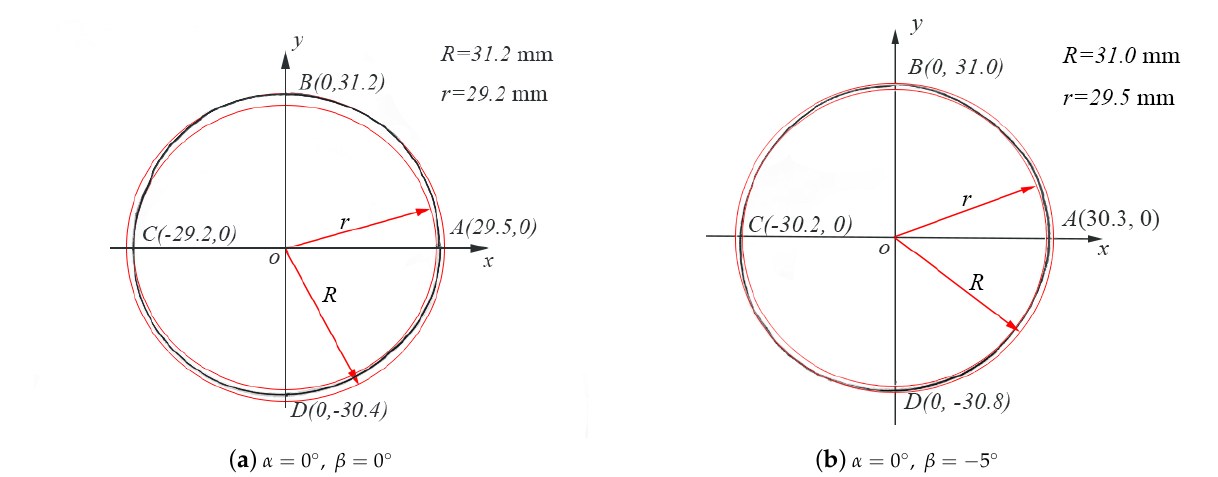
Figure 20. Circular